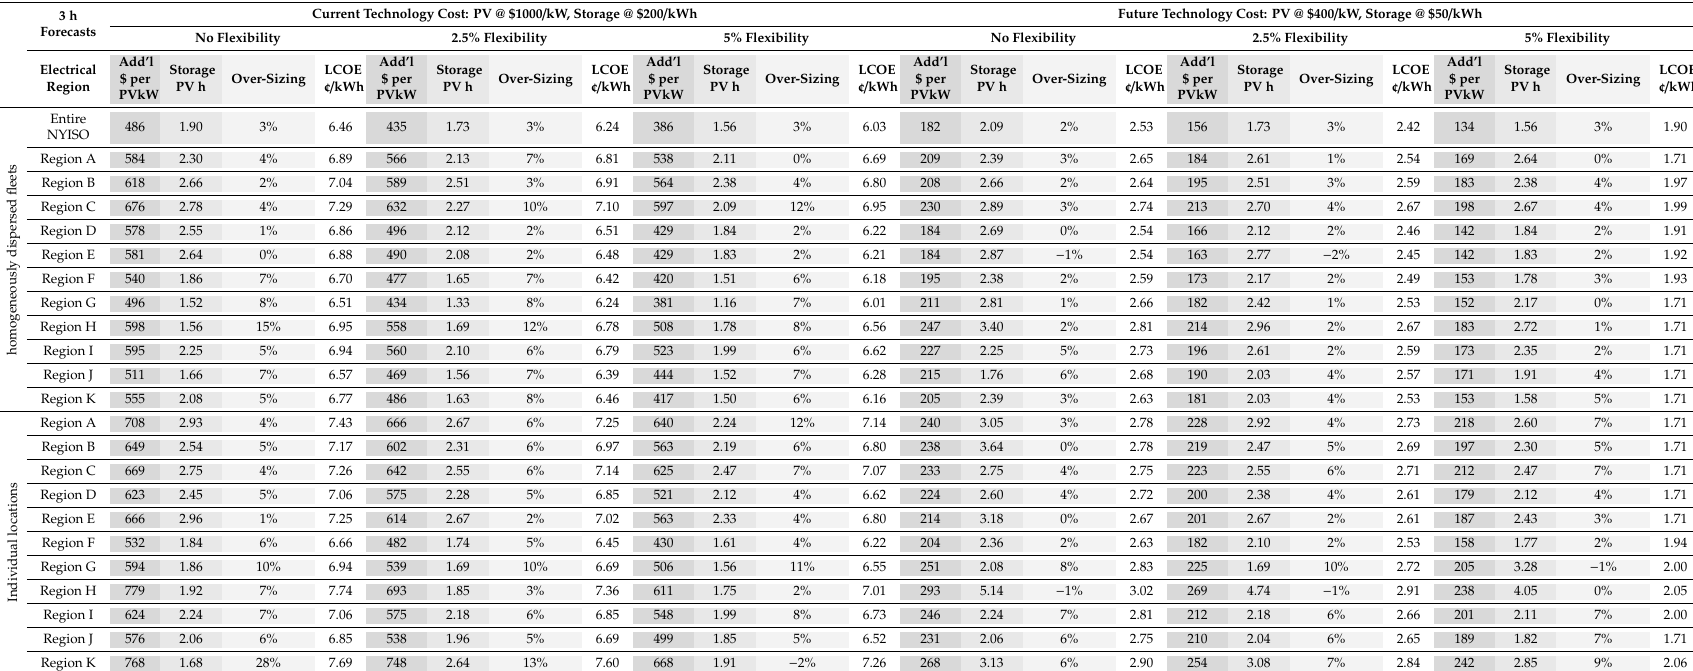
Table A4. Three-hours-ahead firm forecast results applying smart